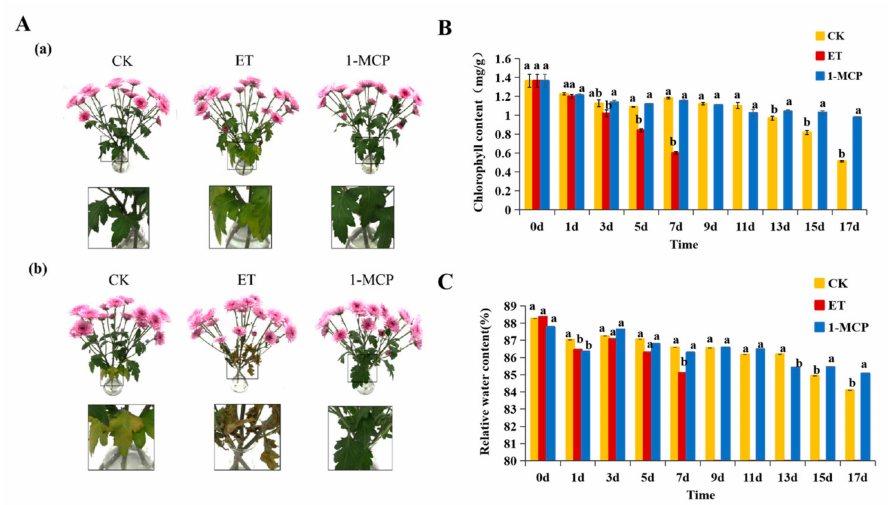
Figure 1. Phenotypic characterization of cut chrysanthemum ‘FenDante’ with ethylene and 1-MCP treatment. ( A ) Vase quality of cut chrysanthemum ‘FenDante’ with ethylene and 1-MCP treatment. ( a ) Vase quality after 7 days of vase treatment; ( b ) Vase quality after 17 days of vase treatment. Black squares indicate the corresponding magnified images. Chlorophyll content ( B ) and relative water content ( C ) of cut chrysanthemum ‘FenDante’ with ethylene or 1-MCP treatment. 1-MCP, 1-methylcyclopropene.